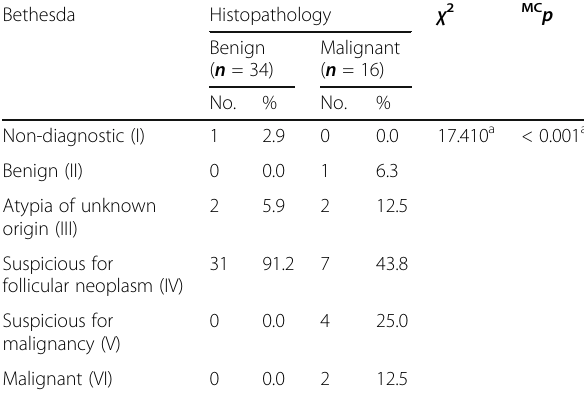
Table 5 Relation between histopathology and Bethesda Bethesda